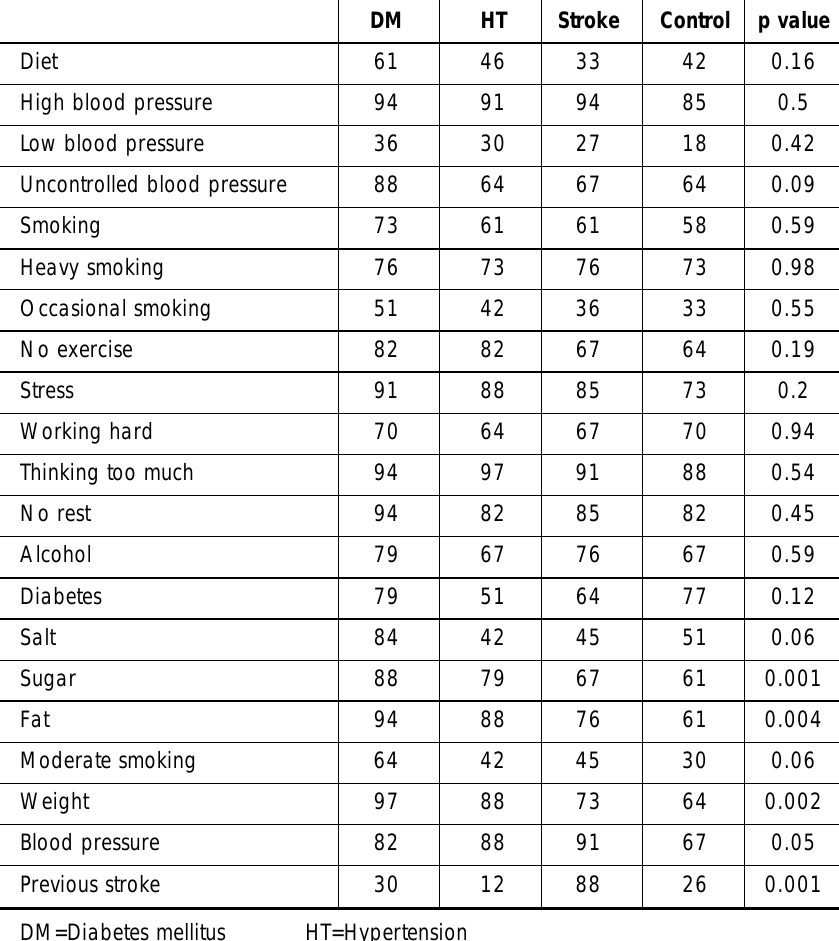
Table 3: Patients’ knowledge of risk factors presented as percentages (True/false questions).